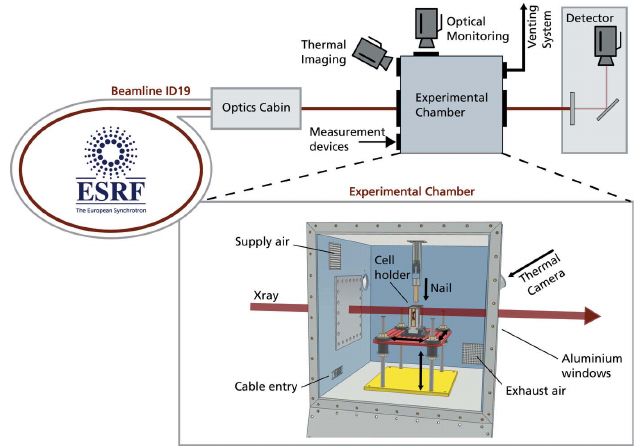
Figure 1 Sketch of the battery abuse-test chamber installed at the ESRF beamline ID19 including an overview of the setup at the beamline and a detailed description of the